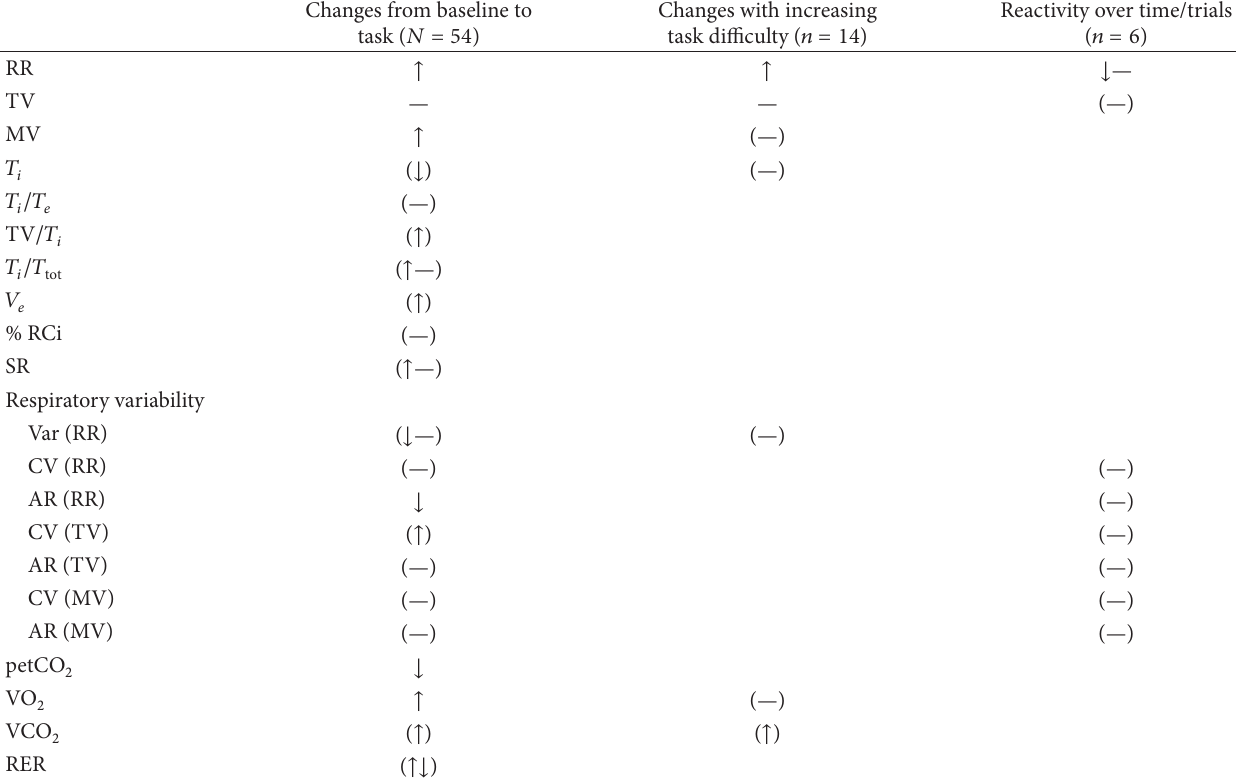
Table 3: Overview of respiratory changes in response to reviewed cognitive tasks. Changes from baseline to Changes with